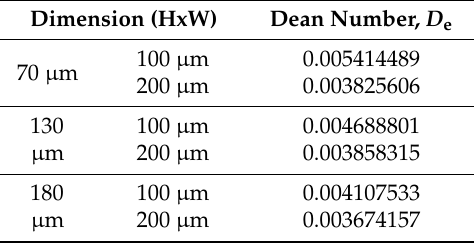
Table 3. The relationship between the dimension of the microchannel and the Dean number.